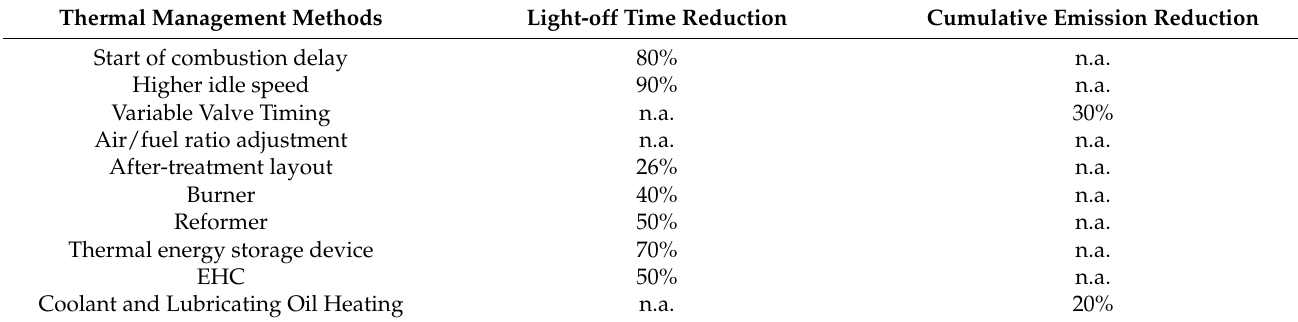
Table 3. Overview of catalyst light-off time reductions and the cumulative emission reductions with different thermal management methods. Adapted from